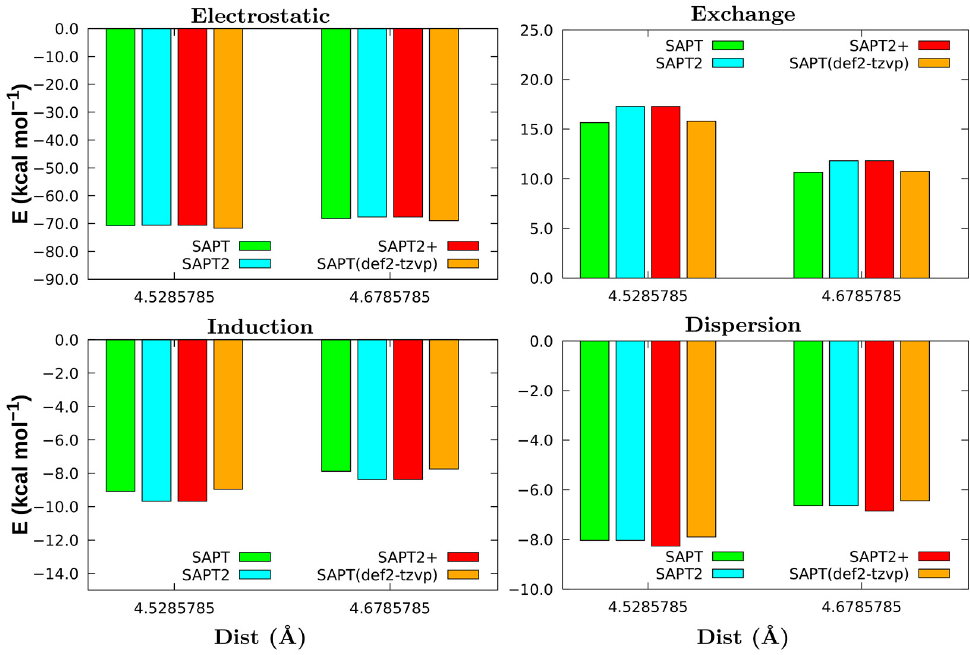
Figure 3. Comparison of different SAPT methodologies for the closed-shell [Bmim][ZnCl 3 ] MIL.